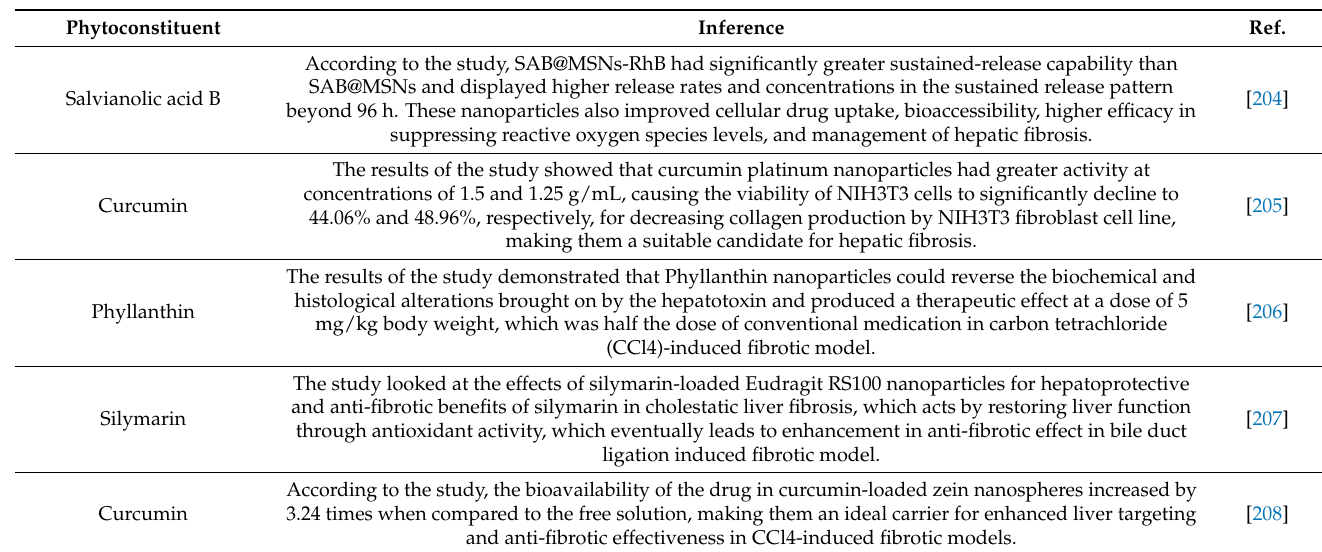
Table 3. Breakthrough in nanotechnology-based applications of medicinal plants extracts and their bioactive compounds in therapeutics of liver